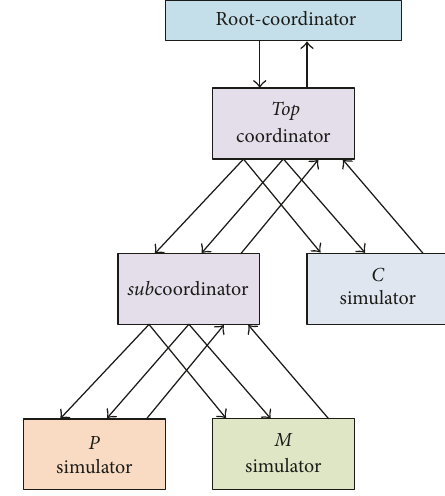
Figure 7: Cosimulation environment as a hierarchical